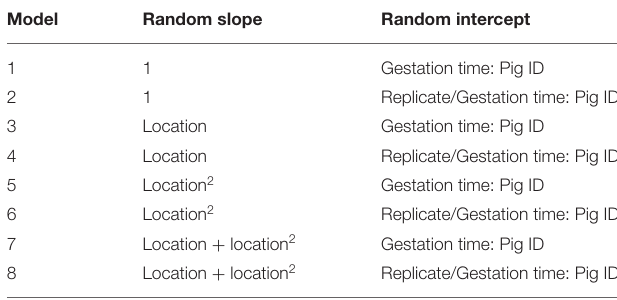
TABLE 1 | Statistical model